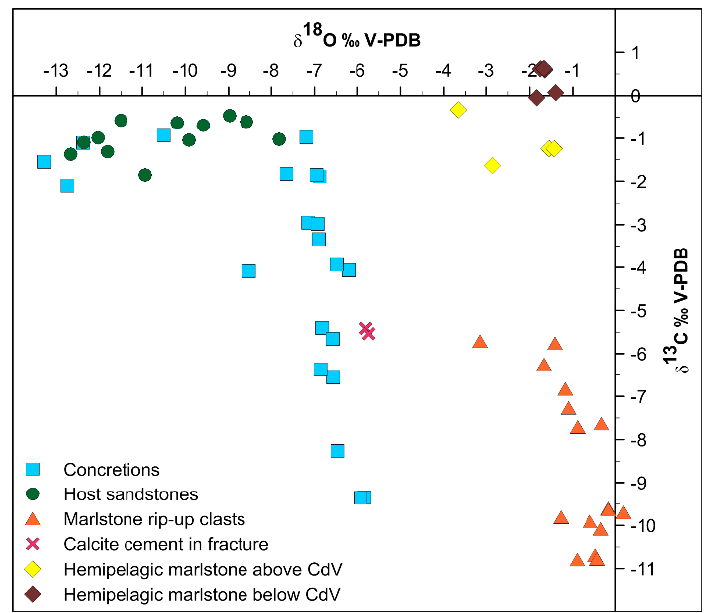
Figure 14. Scatter plot of δ 13 C and δ 18 O measured values from the CdV concretions and host sandstones, fracture filling calcite, marlstone rip ‐ up clasts and the hemipelagic marlstone underlying and overlying the CdV. The C and O stable isotopes of the concretions are interpreted to reflect the δ 13 C and δ 18 O of the calcite cement, whereas that of the host sandstones mirror the δ 13 C and δ 18 O of carbonate lithic fragments, because they represent the only carbonate component present in the host sandstones. C and O stable isotopes support the interpretation that the calcite cement precipitated during burial diagenesis with the carbonate ions deriving from the alteration and dissolution of the hemipelagic marlstone rip ‐ up clasts embedded within the sandstones.